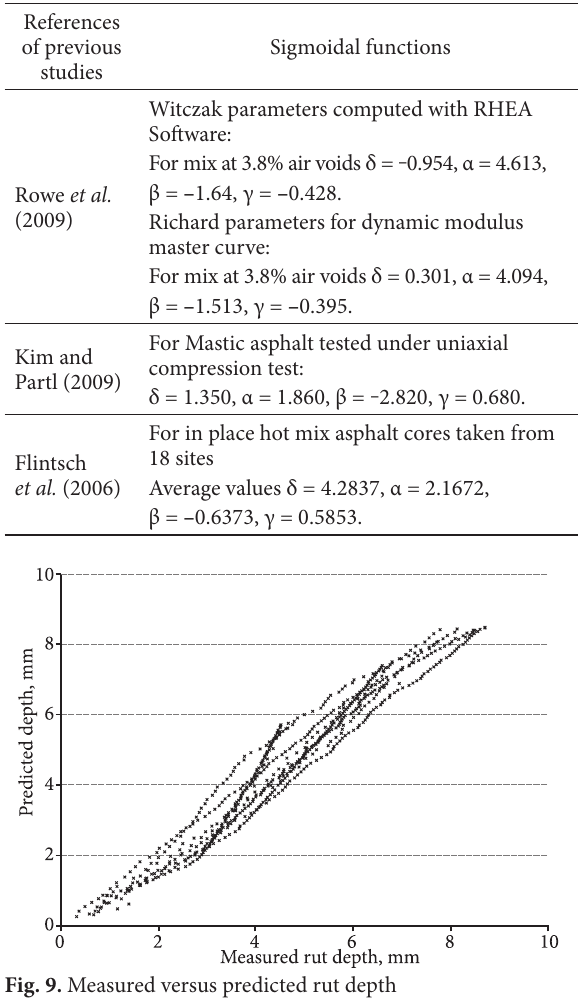
Table 4. Sigmoidal functions reported in other studies